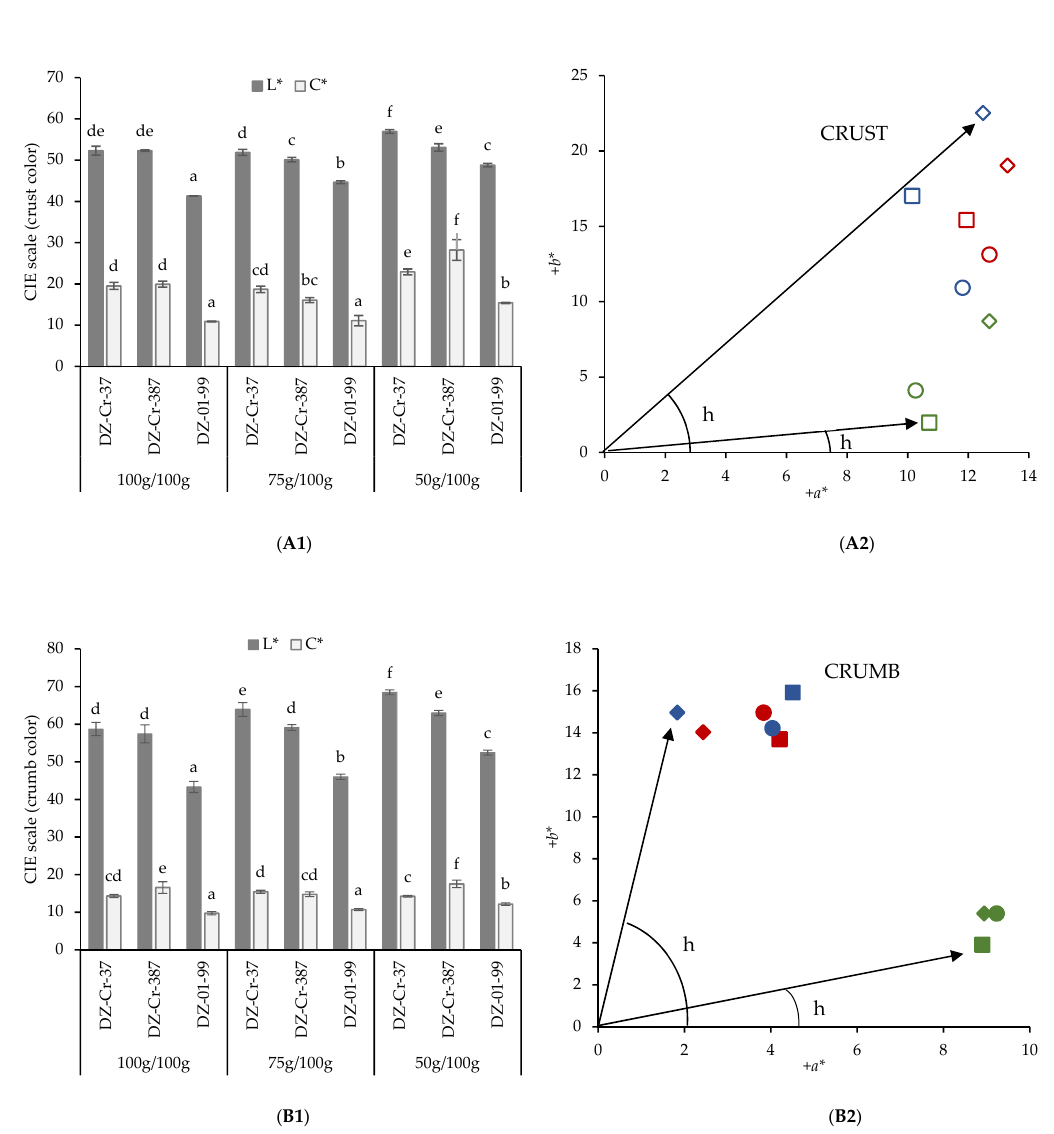
Figure 2. Influence of tef flour addition level and variety on crust ( A ) and crumb ( B ) bread color. Crust and crumb lightness and chroma ( A1 , B1 ) and hue ( A2 , B2 ) of maize starch/tef flour GF breads. Red symbols represent breads made with the DZ-Cr-37 variety, blue symbols the DZ-Cr-387 variety and green symbols, the breads made with DZ-01-99 variety. Squares represent the 100 g/100 g dose, circles represent the 75 g/100 g dose and diamonds, the 50 g/100 g dose. The hue of the indicated samples (located at extreme angular positions in the chromatic diagram) is represented by the angle identified as h. In Figures ( A1 ) or ( B1 ) columns of the same series with a letter in common correspond to values that are not significantly different ( p >